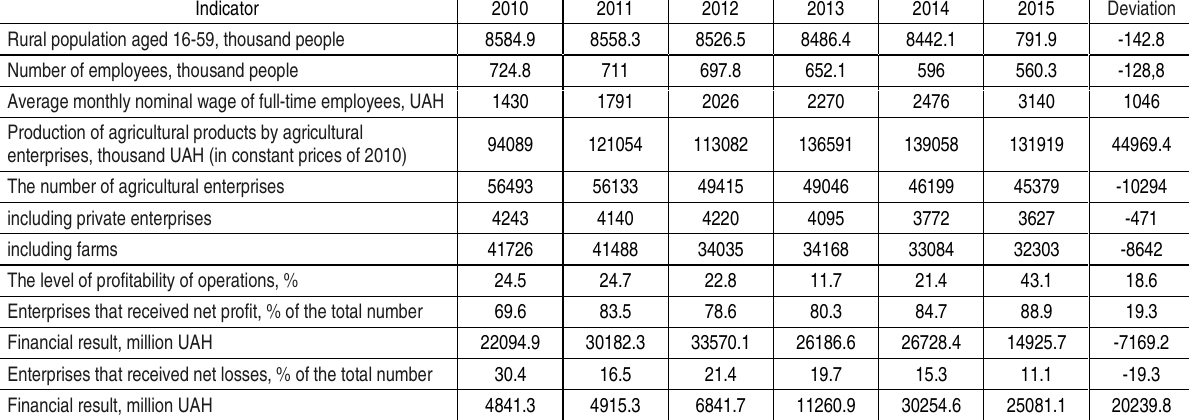
Table 1. Selected indicators of the development of agricultural enterprises in Ukraine in 2010-2015